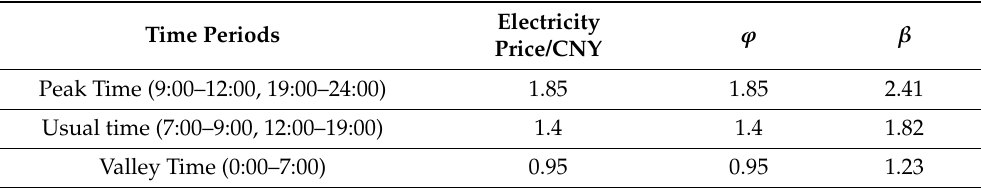
Table A1. The time-of-use electricity price and the value of ϕ , β .